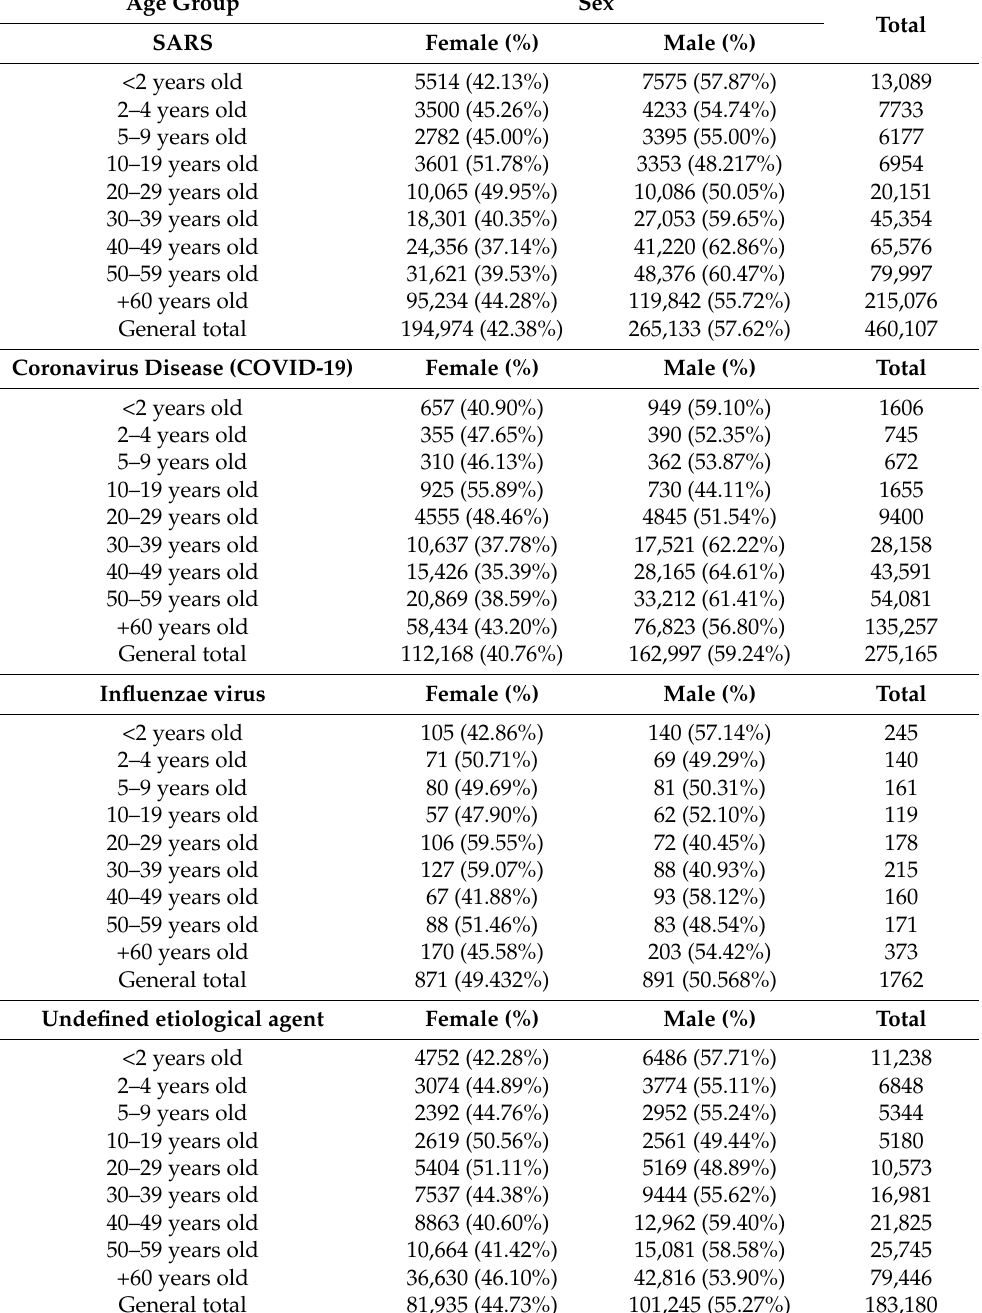
Table 1. Profile of severe acute respiratory syndrome (SARS) in